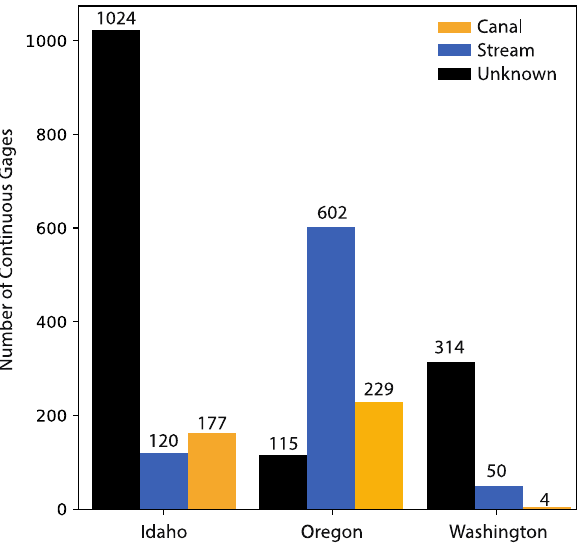
Figure 6. Stream characterization represented by the continuous measurement locations.